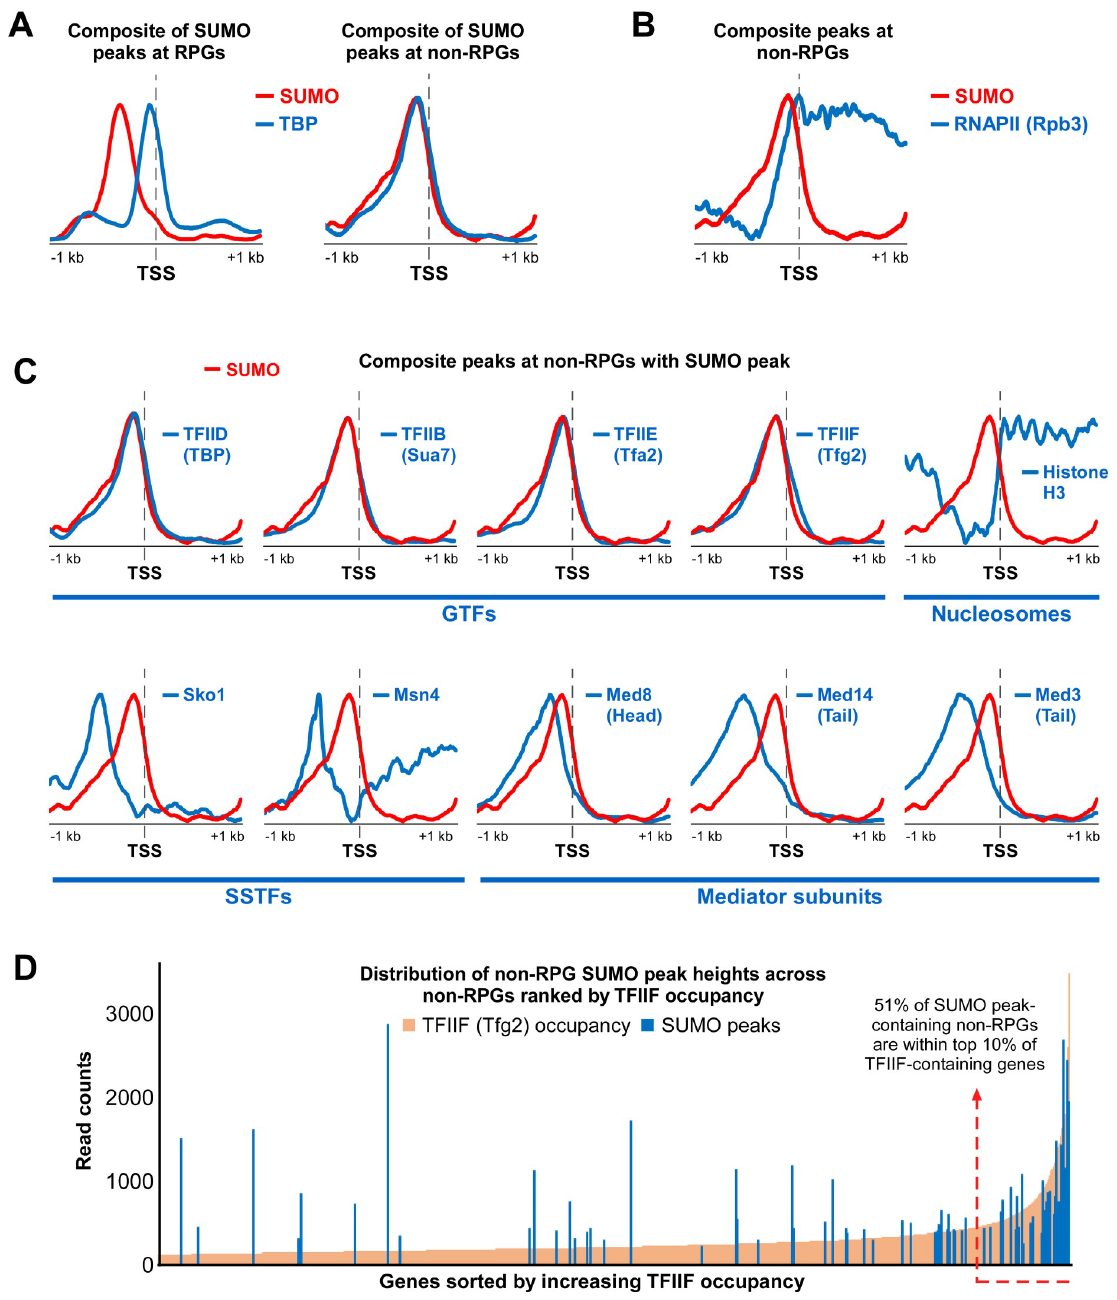
Fig 3. SUMO peaks at promoters of non-PRGs align specifically with GTF components. (A) Comparison of SUMO and TBP composite plots at SUMO peak-containing RPGs (left) and non-RPGs (right), shown relative to the TSS position. SUMO plots were generated with data from Replicate 1 of our SUMO ChIP-seq analysis, whereas TBP data were obtained from NCBI GEO database (accession number GSM2870615). (B) Comparison of SUMO and RNAPII (subunit Rpb3) composite plots at SUMO peak-containing non-RPGs. Rpb3 data were obtained from the GEO database (accession number GSM3629815). (C) Composite plots for GTF subunits, histone H3, sequence- specific transcription factors (SSTFs), and Mediator subunits were compared with SUMO composite plots at SUMO peak-containing non- RPGs. All datasets, except for SUMO (as described in A ), were obtained from the GEO database, with the following accession numbers: Sua7 (TFIIB subunit): GSM4319112; Tfa2 (TFIIE subunit): GSM4319116; Tfg2 (TFIIF subunit): GSM4319120; H3: GSM2561057; Sko1: GSM3335975; Msn4: GSM1859030; Med8 (Mediator head subunit): GSM3189528; Med14 (Mediator tail subunit): GSM3189529; and Med3 (Mediator tail subunit): GSM3189530. (D) Distribution of SUMO peak-containing non-RPGs by TFIIF occupancy level. The 111 SUMO peaks (blue) associated with single non-RPGs were plotted, by normalized read count, over the ranked distribution of TFIIF (subunit Tfg2) occupancy levels (ChIP-seq counts per million) over all Tfg2-containing non-RPGs. Tfg2 occupancy levels derived from GEO database (accession